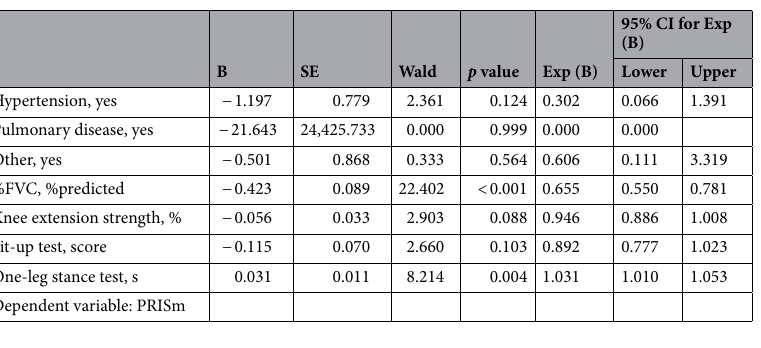
Table 5. Logistic regression analysis with the presence or absence of PRISm as the dependent variable.